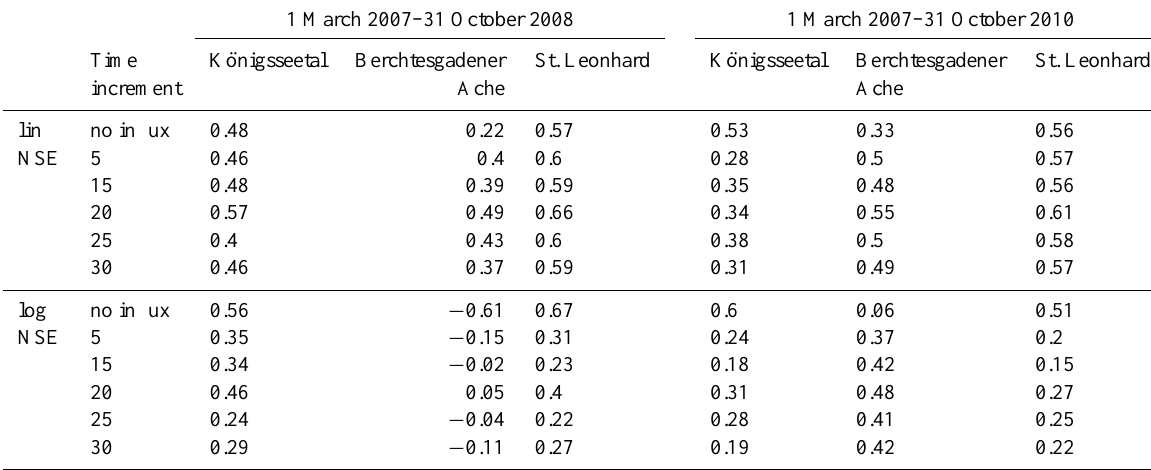
Table 8. Performance of the hydrological model correction 1 March 2007–31 October 2008 and 1 March 2007–31 October 2010. Values are linear and logarithmic Nash Sutcliffe